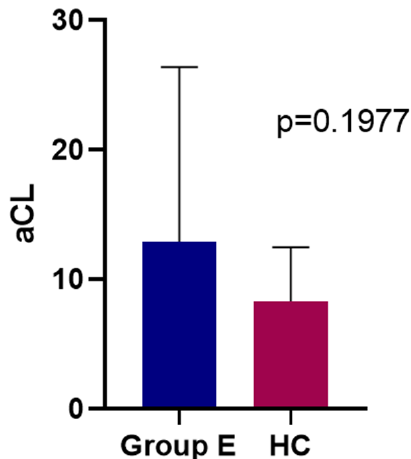
Figure 4. aCL IgM titers at baseline for Group E MDD patients (Mean = 12.9 μ g/ml) and HC (Mean = 8.322 μ g/ml).